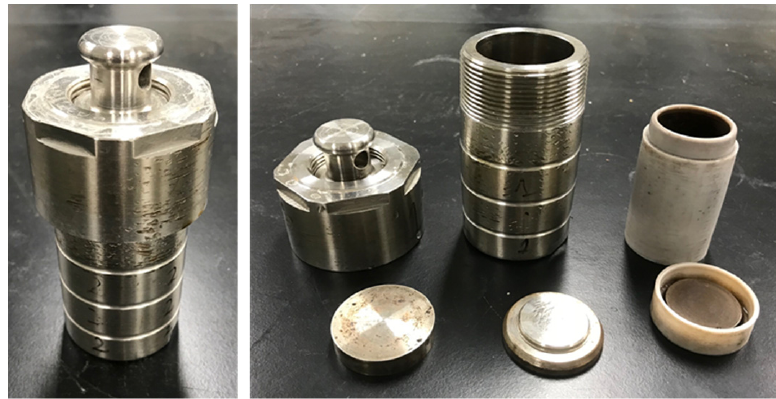
Figure A3. Polytetrafluoroethylene lined stainless-steel batch reactor.